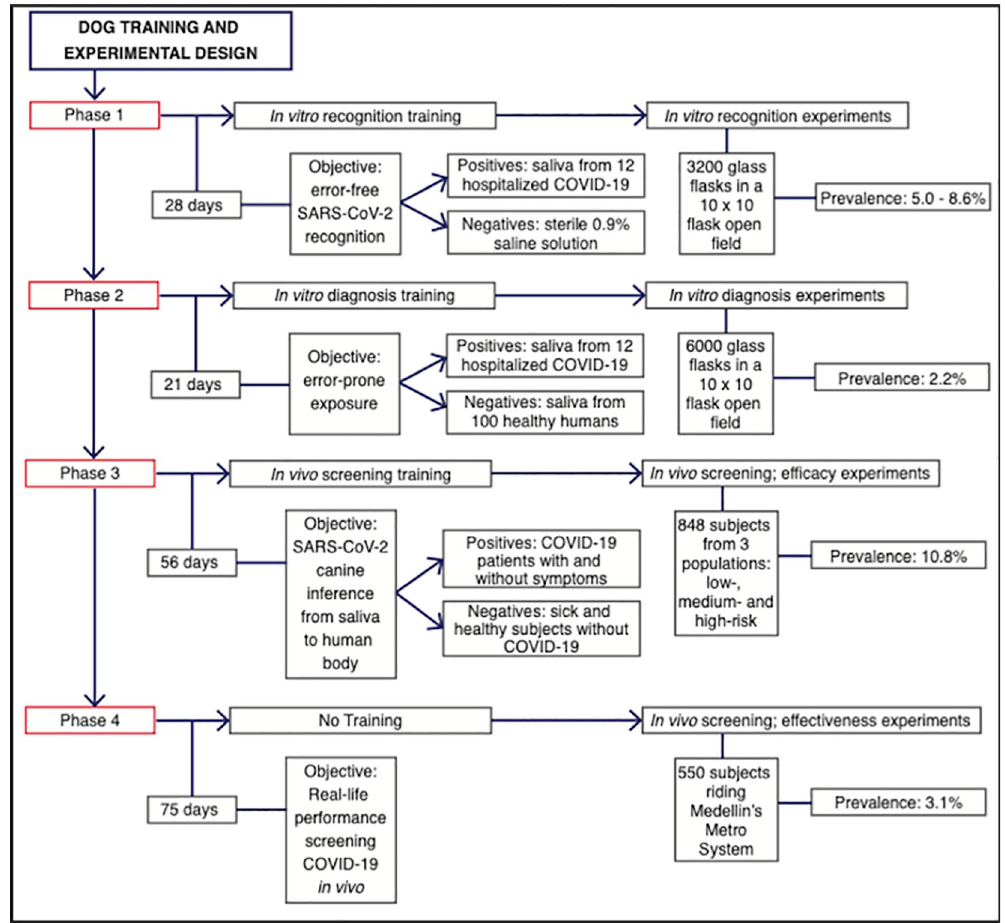
Fig 1. Efficacy studies. Flow chart depicting the order in which training phases and experimental design were conducted. The number of days after phases 1, 2, and 3 indicate the time employed training the dogs before running efficacy experiments; in the case of phase 4, the time without training before starting the effectiveness experiments. COVID-19 prevalence was set up as desired for in vitro experiments, introducing a more difficult scenario by minimizing prevalence during phase 2 (in vitro diagnosis). Prevalence during phases 3 and 4 (in vivo screening) was spontaneous, given by the pandemic epidemiology of the different human groups participating in the study.